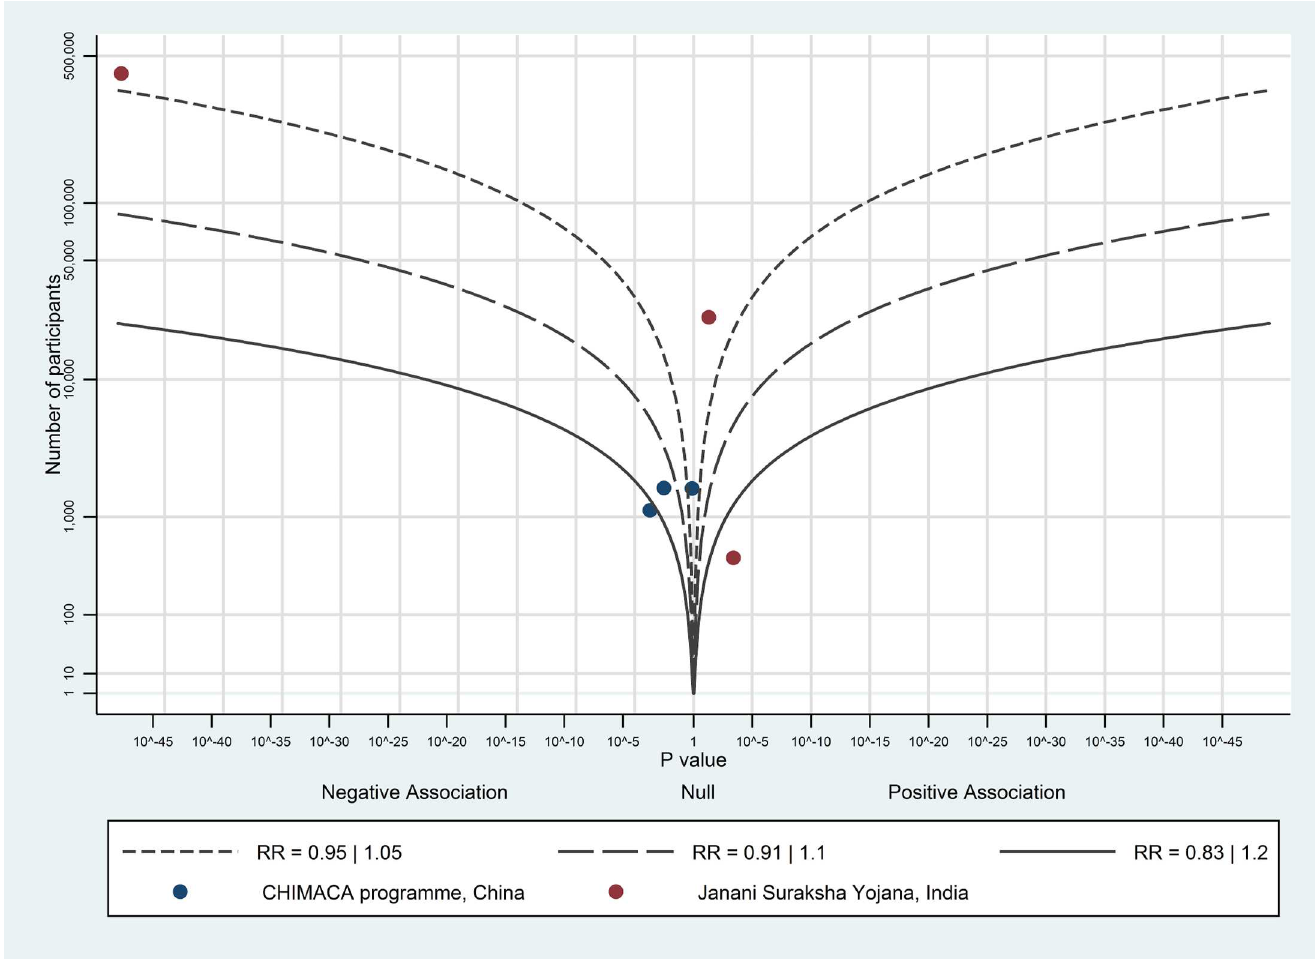
Fig 8. Albatross plot for effect of short-term cash payments on postnatal care for mothers and newborns.